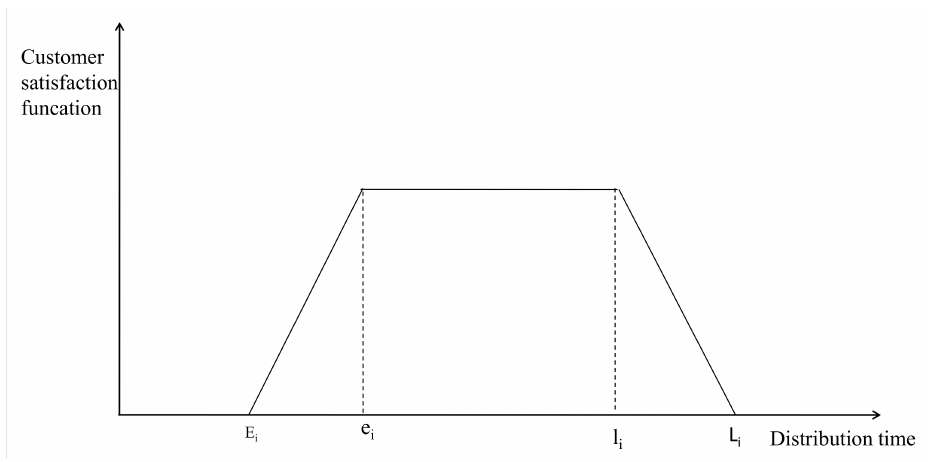
Figure 8. Customer satisfaction function graph